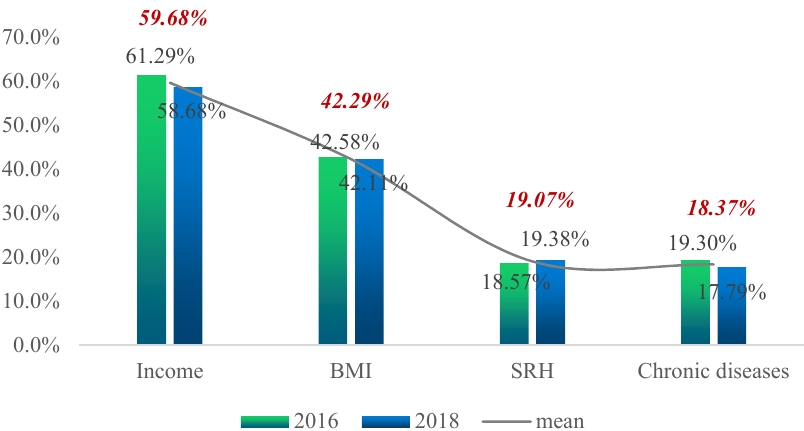
Figure 2. Proportion of the poor for each indicator of the economic income dimension and the individual health endowment dimension.